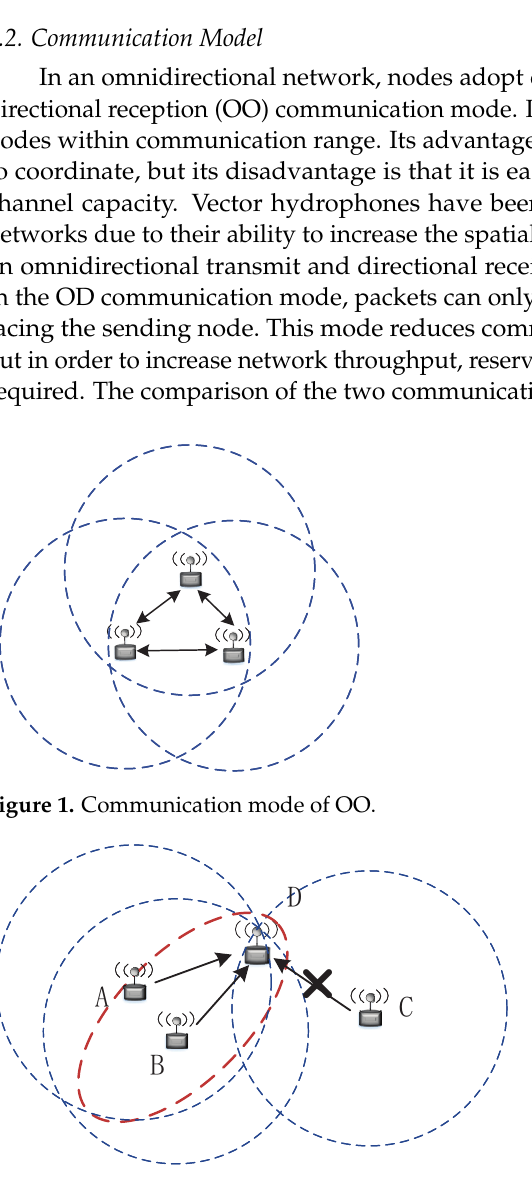
Figure 2. Communication mode of